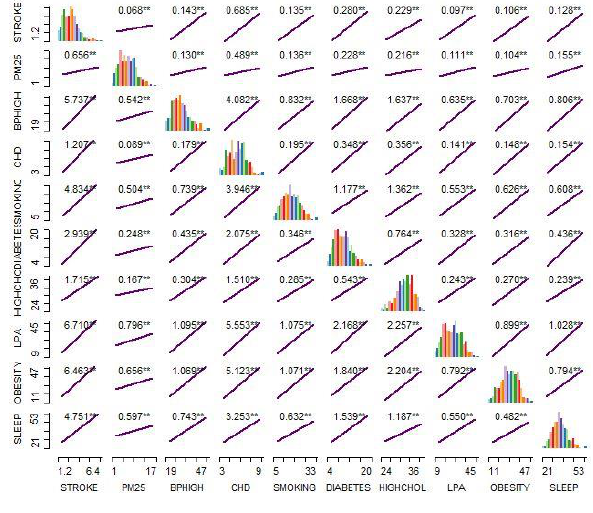
Figure 2. Scatter